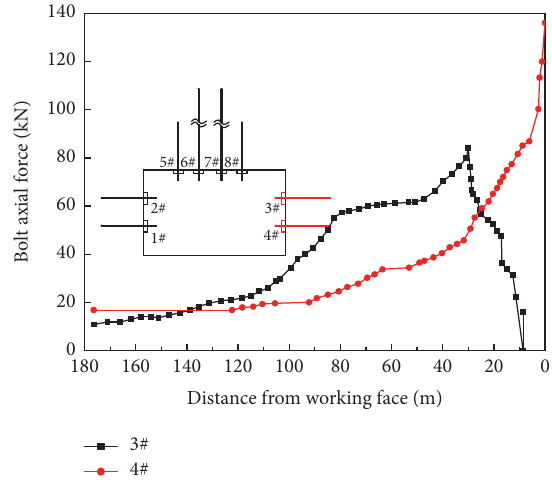
Figure 18: Stress of side bolt at 5# station in the nonhydraulic fracturing section.